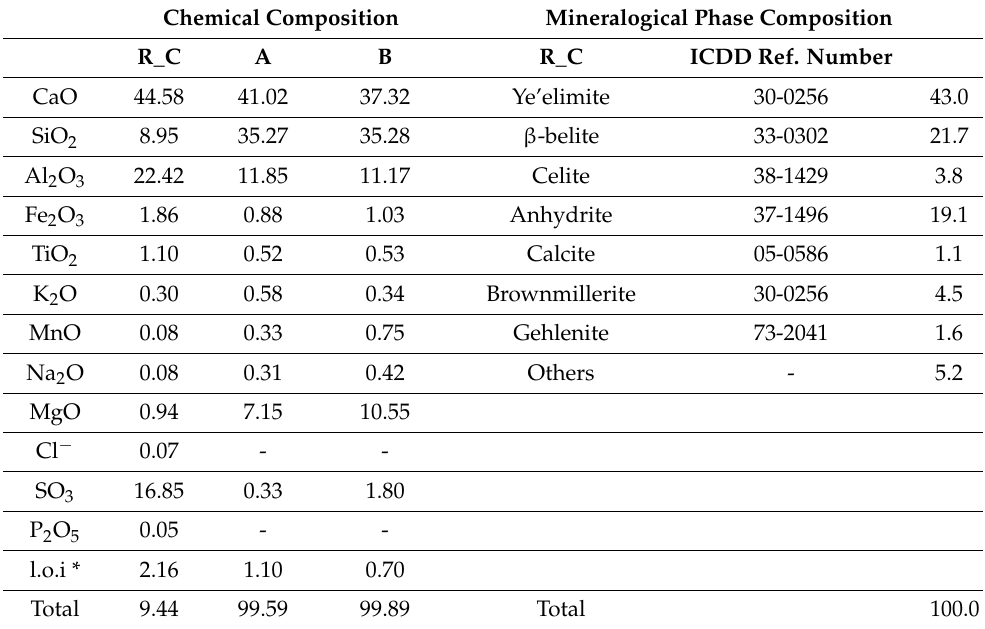
Table 1. Chemical and mineralogical (only for R_C) composition for the binder components, wt%.